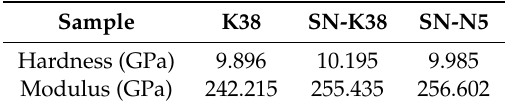
Figure 1. Fractured and transmission electron microscopy (TEM) bright field microstructure ( A ) and cross-sectional ( B) morphologies of the as-sputtered SN-K38 coating, cross-sectional ( C ) morphology of the as-sputtered SN-N5 coating, ( D ) chemical composition (wt.%) measured by energy-dispersive spectrometry (EDS) analysis at the sectional area denoted in ( B , C ). Table 3. Nominal composition of the superalloy K38 (wt.%).